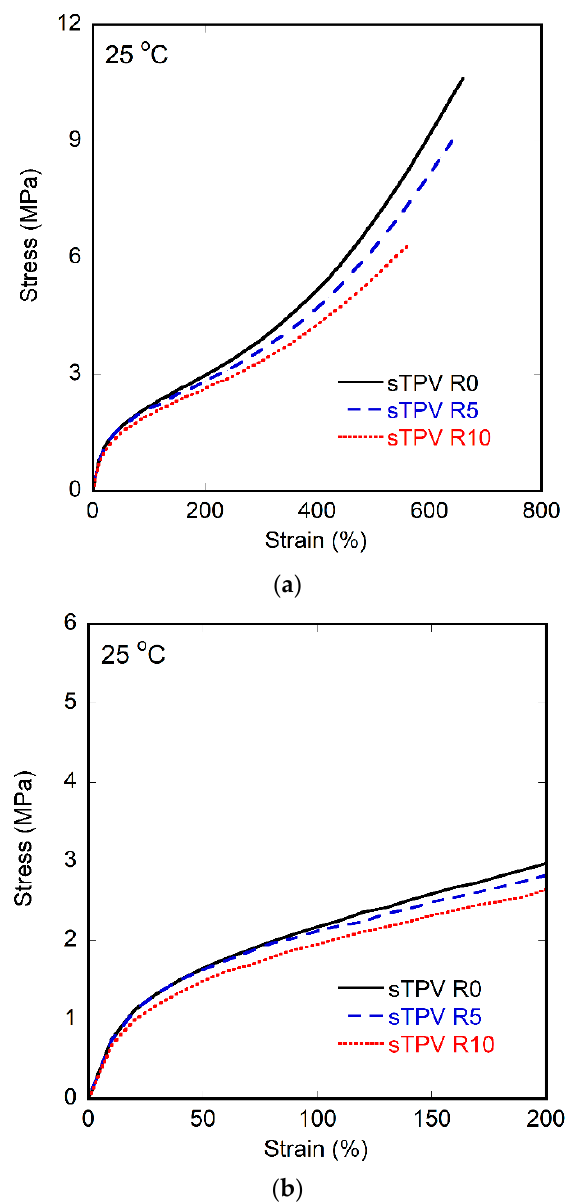
Figure 7. Stress–strain curves of sTPV that was reprocessed 0, 5, and 10 times ( a ) overall ( b ) 0–200% strain. Table 4. Tensile properties of samples prepared via the Split-DV method (sTPV) after 0, 5, and 10 reprocessed